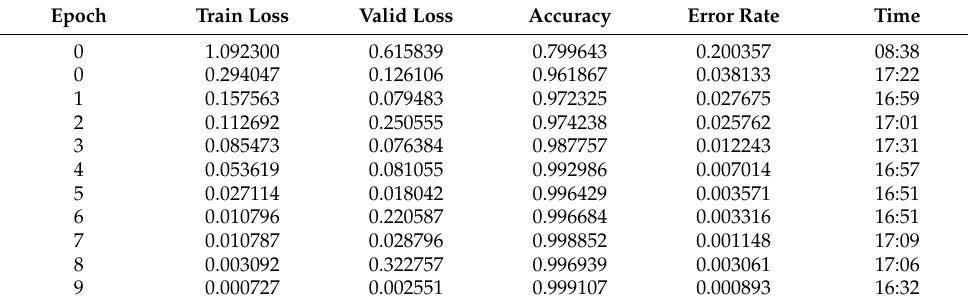
Table 6. Results of the SqueezeNet